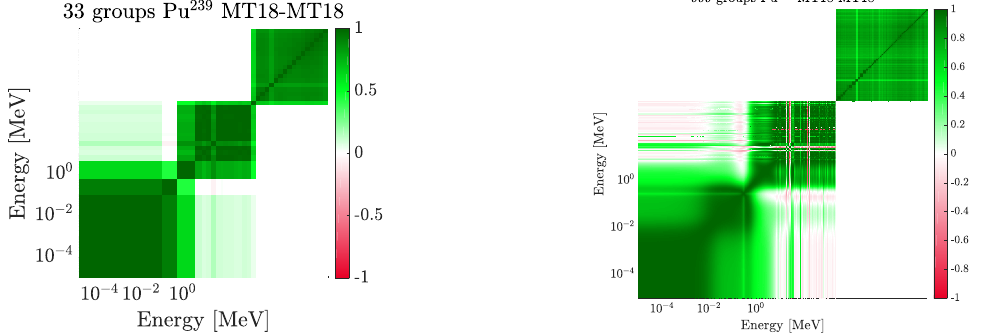
Figure 1: ECCO 33-groups correlation matrices for MT18 (left) and corresponding equally lethargy spaced 999 groups correlation matrices